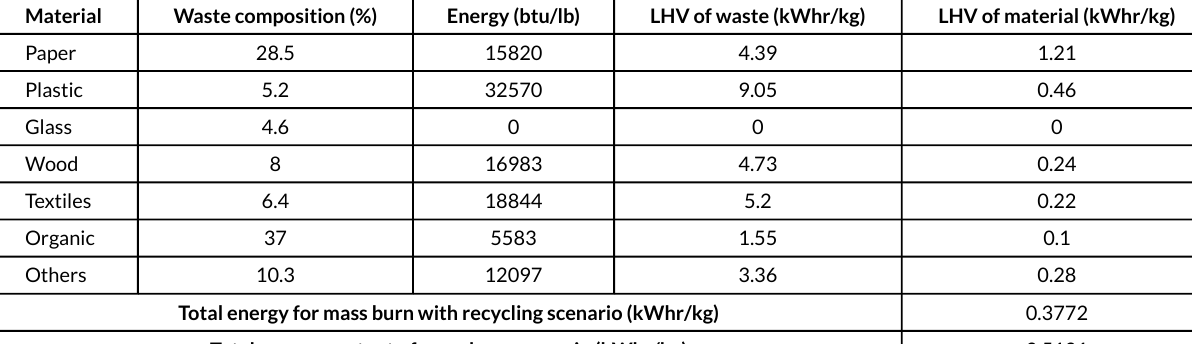
Table I. Municipal Solid Waste (MSW) energy content in the KSA.